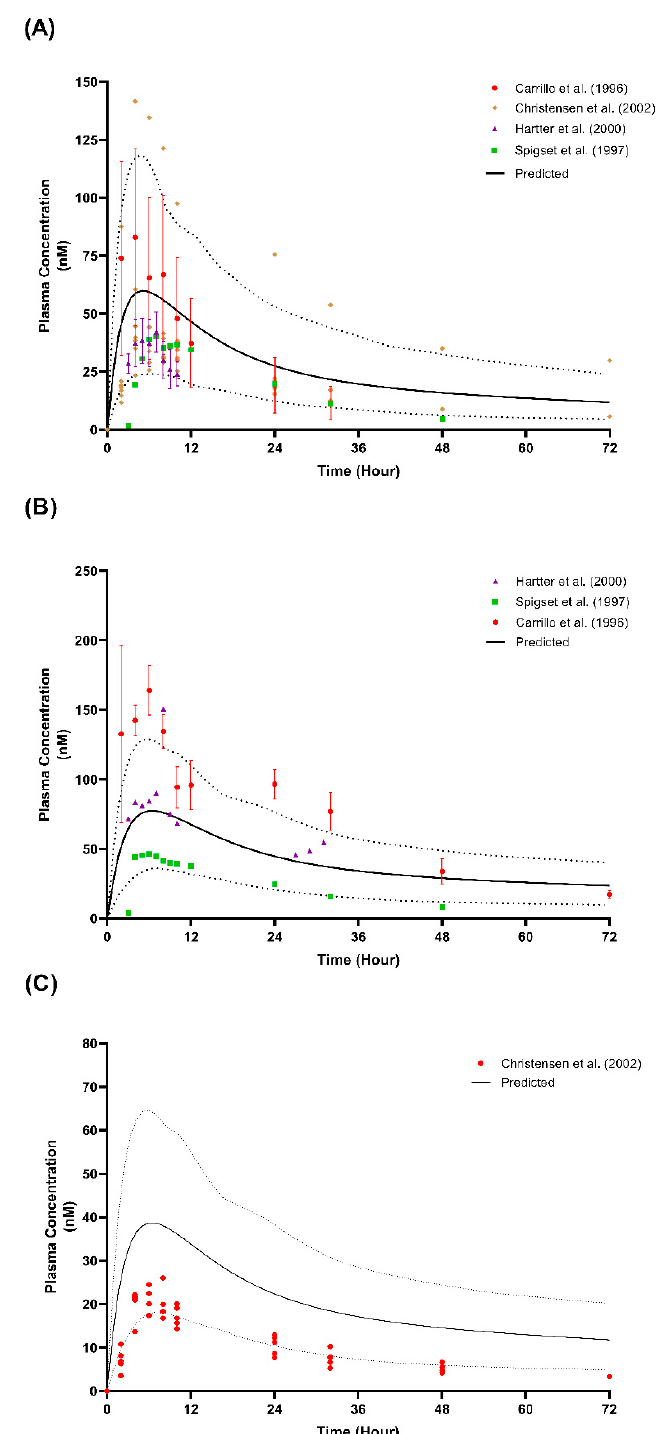
Figure 6. Simulated single-dose studies in model validation for CYP2D6 phenotype. ( A ) Single-dose 50 mg in EM CYP2D6 population [48–51]; ( B ) single-dose 50 mg in PM CYP2D6 population [48–50]; ( C ) single-dose 25 mg in PM CYP2D6 population [51]; solid lines represent the mean predicted concentration-time profile, with dotted lines representing the 5th and 95th percentile ranges. Solid circles represent observed clinical data from each study, with error bars indicating SD.